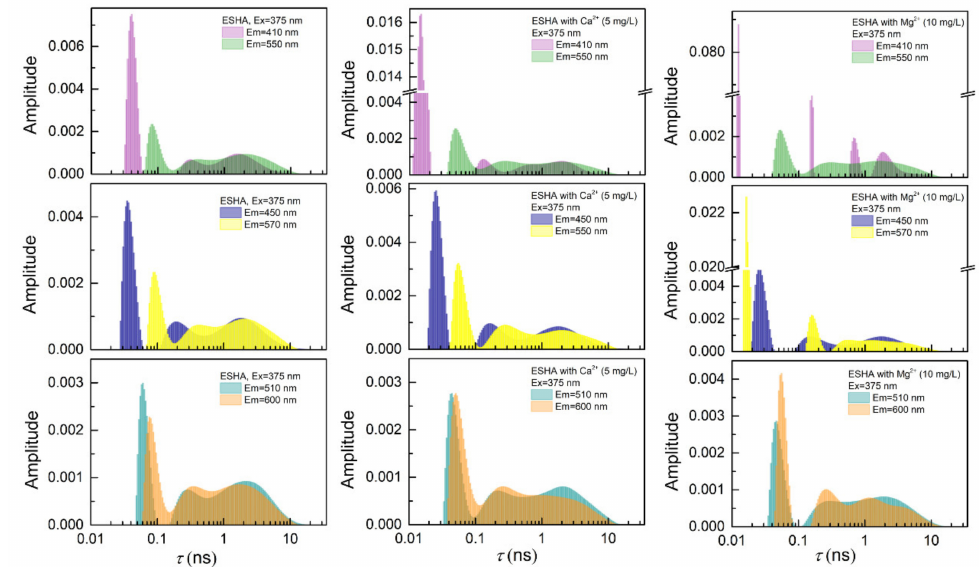
Figure 5. Lifetime distributions for emission decays of ESHA (10 mg C/L) aqueous solution at excitation of 375 and 440 nm, Mg 2+ (10 mg/L) and Ca 2+ (5 mg/L).